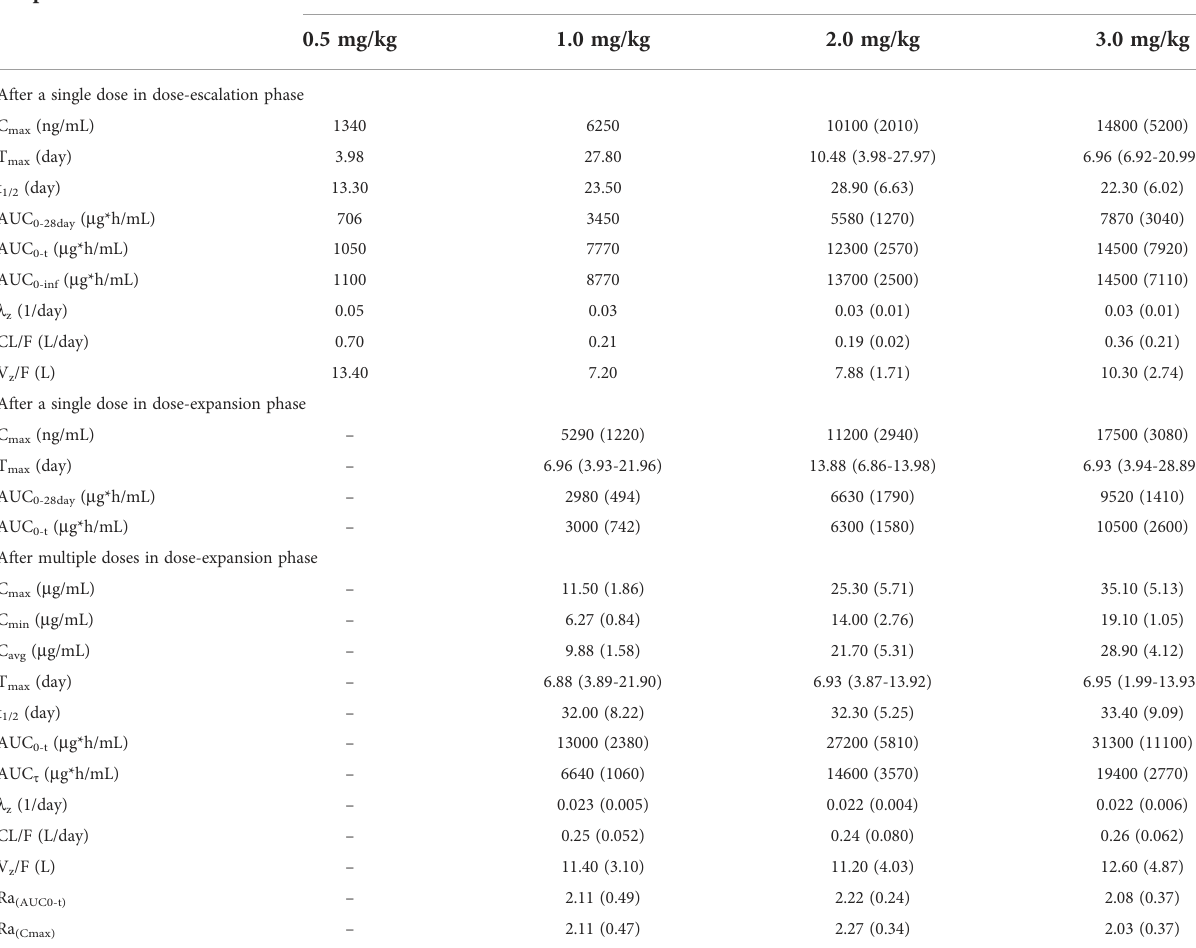
TABLE 4 Summary of plasma pharmacokinetic parameters of JMT103 after single and multiple doses in the PKAS. PK